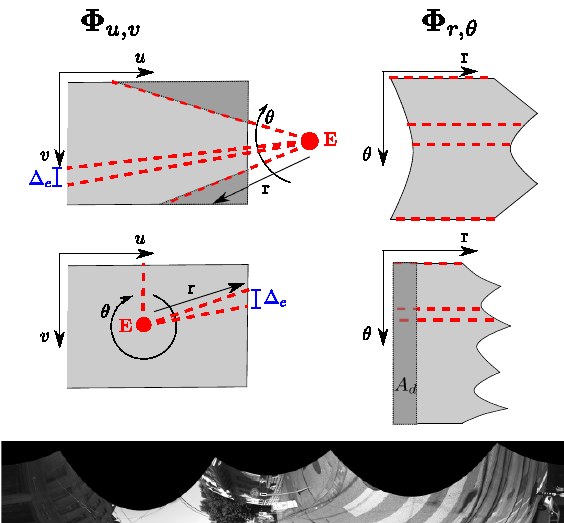
Figure 7. Polar rectification process and rotated polar rectified image (bottom row). Transformation of the epipole is located outside the image (top row) and in the case the epipole is located inside the image (middle row).